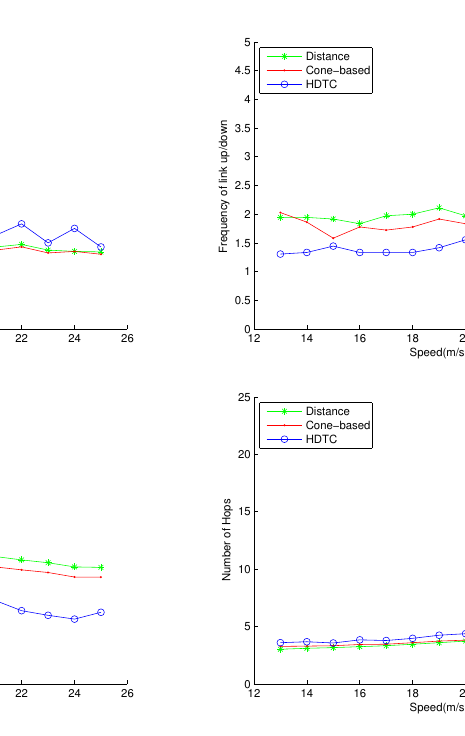
Figure 12. Scenario 1: The connection time, the frequency of the link up/down, the group size and the number of hops with varying the vehicle